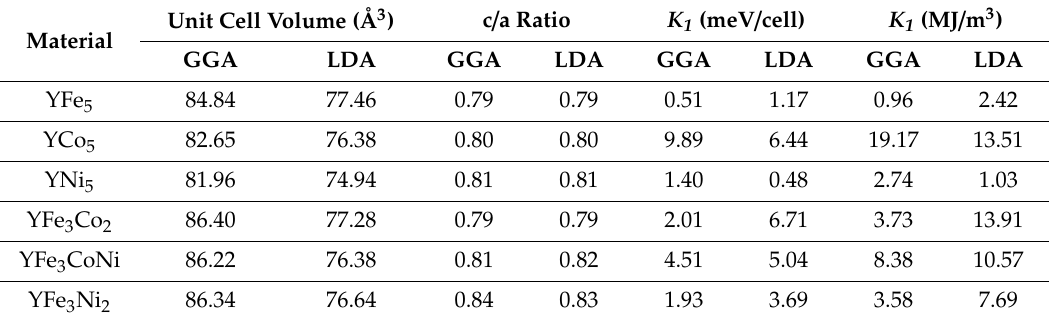
Table 4. FPLMTO results. GGA and LDA refer to generalized gradient approximation and local density approximation, correspondingly. K 1 reflects the magnetic anisotropy energy. Unit Cell Volume (Å 3 Material